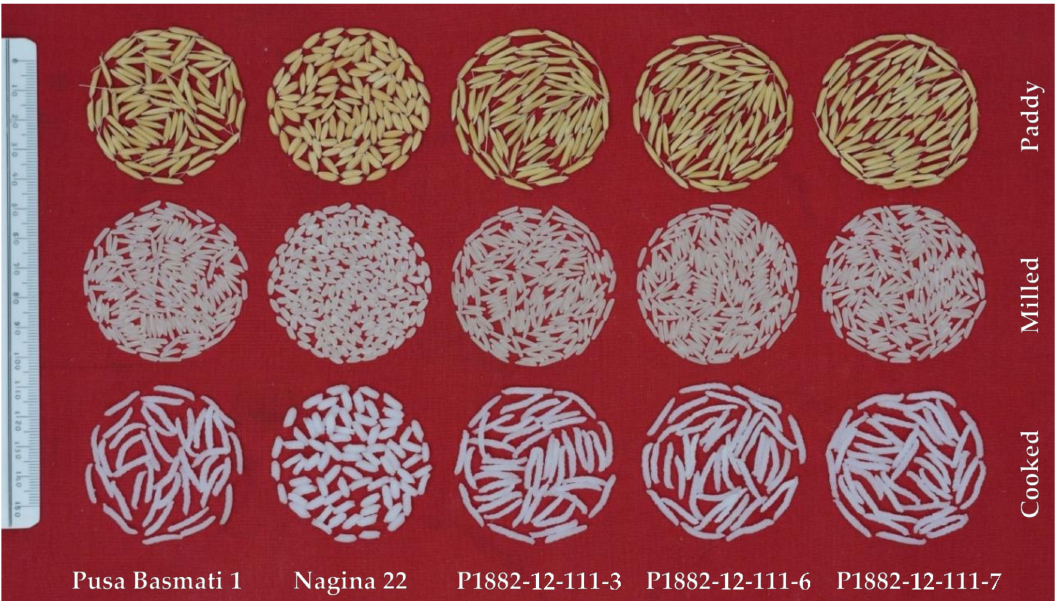
Figure 4. Grain and cooking quality of the representative NILs of Pusa Basmati 1 carrying qDTY 1.1